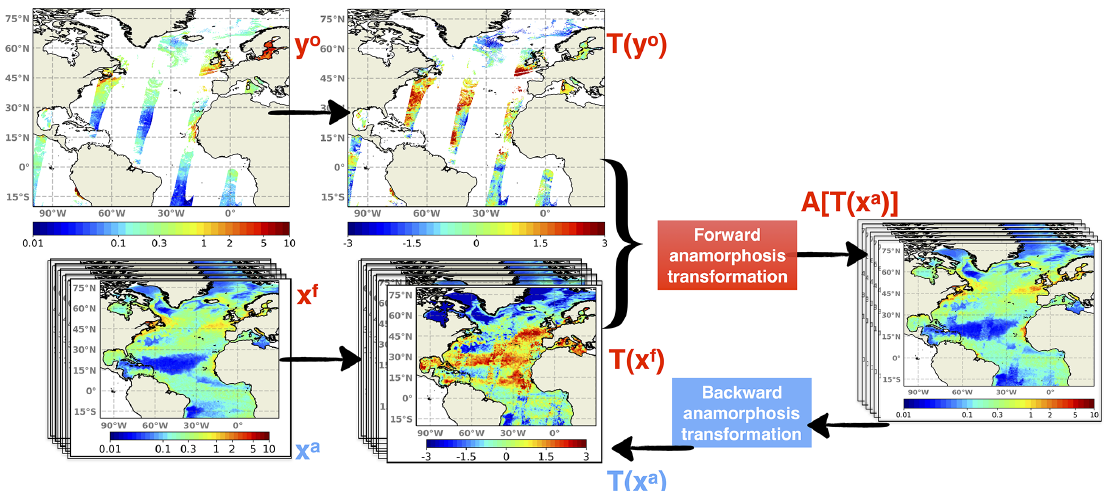
Figure 8. Schematics of the assimilation process including time-independent transformations. Both daily ensemble forecast ( X f ) and daily satellite observations ( y o ) are transformed by their own climatologies. Then they are projected into the anamorphic space prior to entering the analysis step. After the update, the ensemble analysis ( X a ) is converted back to initialize the subsequent daily